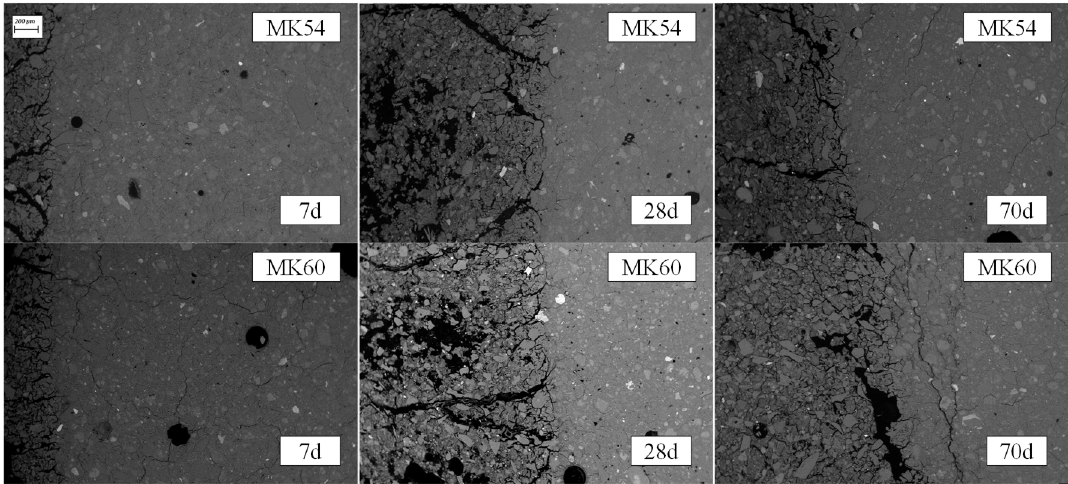
Figure 6. SEM backscatter images of geopolymers MK54 and MK60 after 7 (7 d), 28 (28 d), and 70 (70 d) days of exposure to sulfuric acid, the left side of each image showing the deteriorated layer.